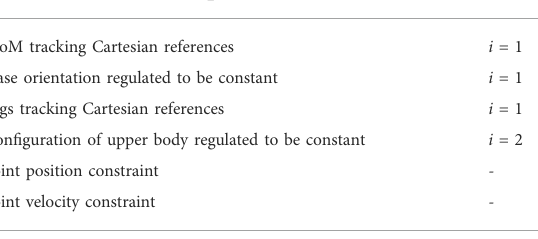
TABLE 1 Tasks and constraints assigned in the whole-body IK